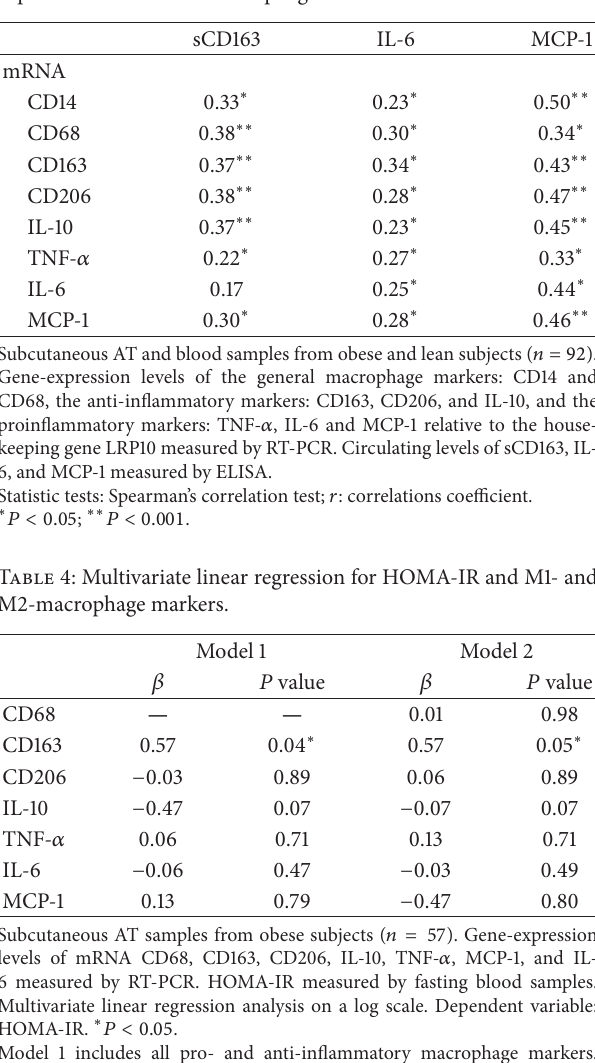
Table 3: Association between serum protein levels and the gene- expression levels of the macrophage markers.